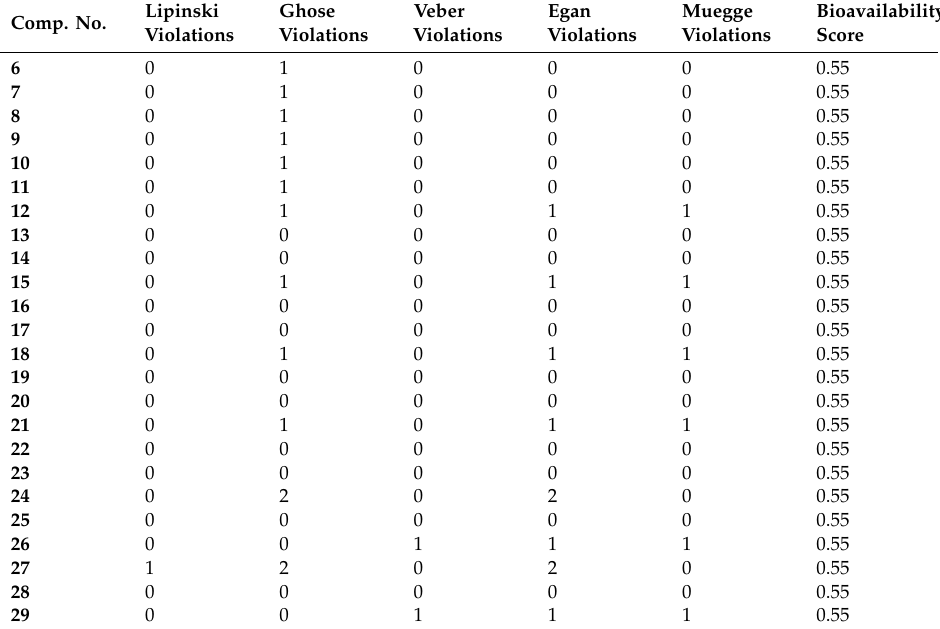
Figure 8. BOILED-Egg diagram of the selected compounds 6–29 . Table 3. Drug likeness predictions of the selected compounds 6–29 .